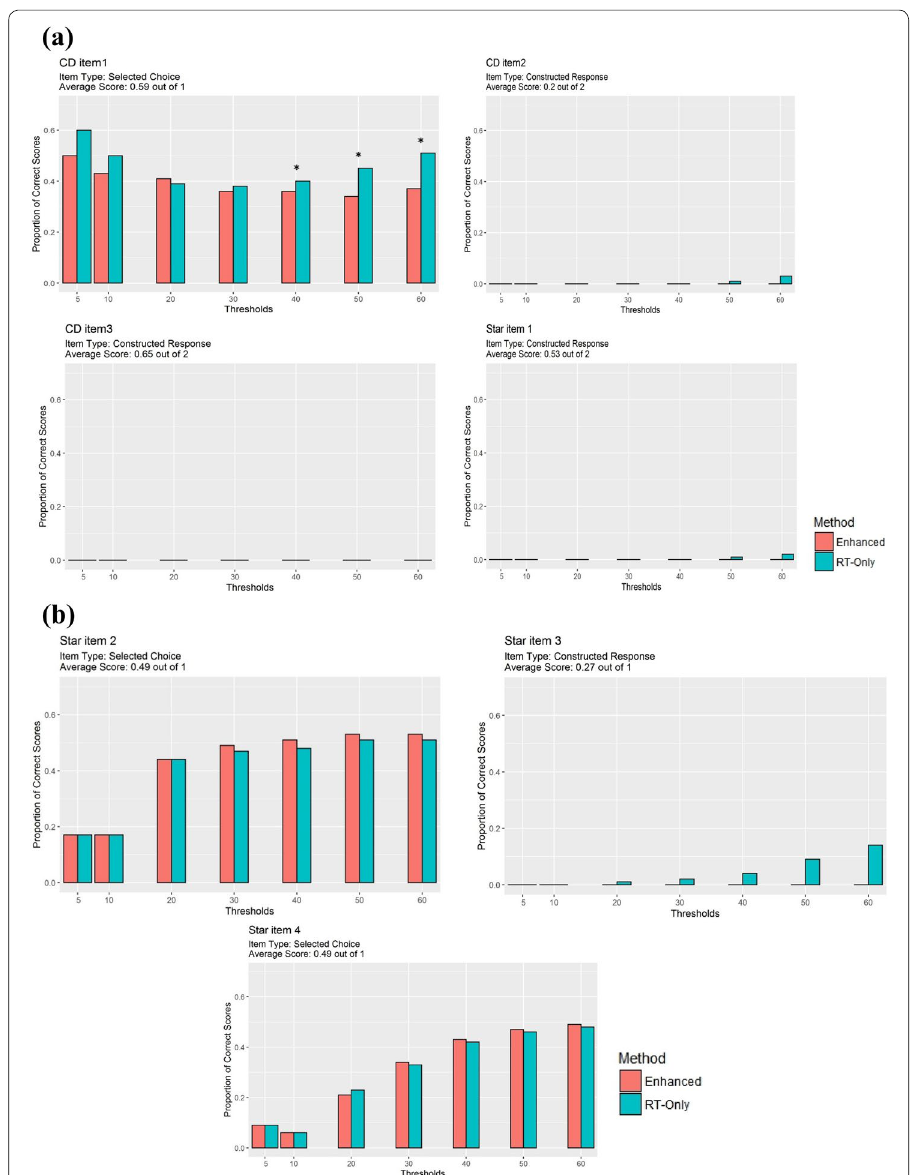
Fig. 4 a Comparison of RT-only and enhanced methods of identifying rapid-disengagement based on proportion of correct scores. The asterisks indicate significant 95 confidence intervals built around the differences in proportions for CD item 1–3, and Star item 1. b Comparison of RT-only and enhanced methods of identifying rapid-disengagement based on proportion of correct scores. The asterisks indicate significant 95 confidence intervals built around the differences in proportions. Star item